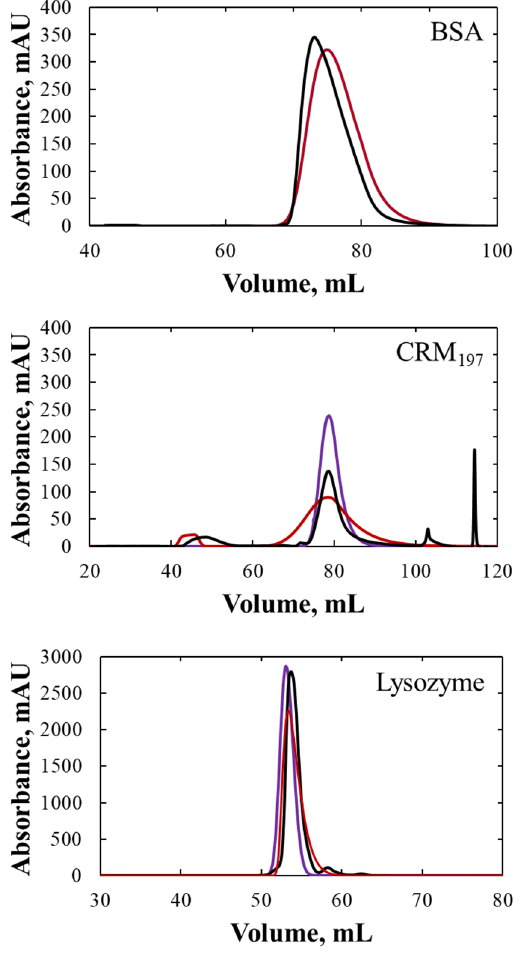
Figure 9. Validation runs for BSA, CRM 197, and Lysozyme to test the DSPX model; the violet line represents the absorbance profile when the model of Mollerup et al. is used, the red line when the model of Wang et al. is used, the black line is the experimental absorbance profile. BSA simulated peaks are overlapped.